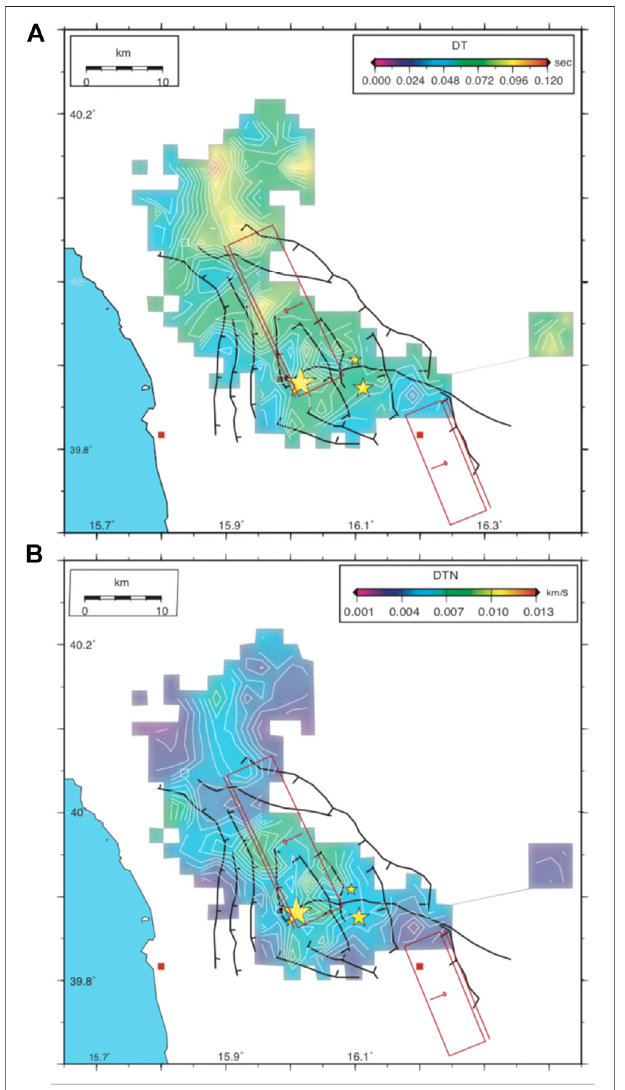
FIGURE 10 | Geographical distribution of (A) delay time and (B) normalized delay time values interpolated on a 2 km spaced grid, by means a nearest neighbor algorithm. FIGURE 11 | (A) Sketch map of the identi fi ed three sectors with similar